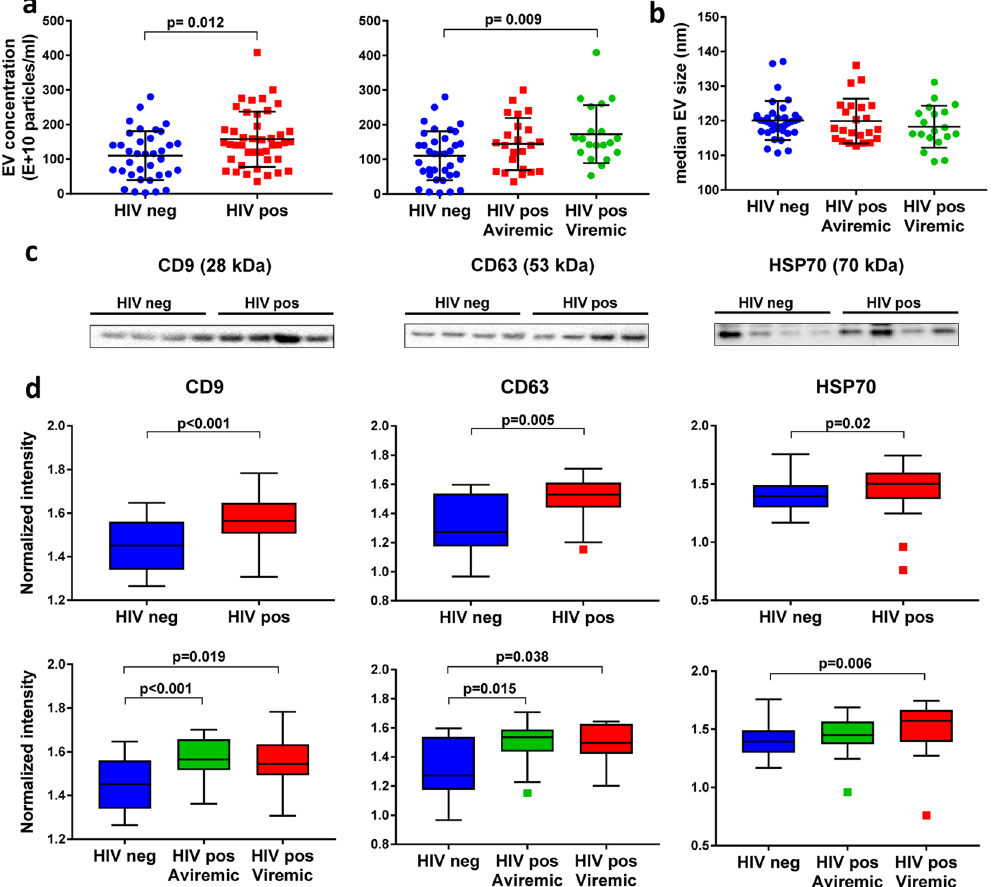
Figure 2. Plasma exosomes and exosome markers CD9, CD63, and HSP70 are elevated in viremic HIV-positive subjects on ART compared to controls. Exosome fractions were isolated from plasma (0.4 ml) of HIV-positive subjects (aviremic and viremic with viral load < 400 and 400–2500 HIV RNA copies/ml, respectively) and HIV-negative controls. Beeswarm plots show EV concentration ( a ) and median size ( b ) measured by NTA in aviremic (n = 23) and viremic (n = 20) HIV-positive versus HIV-negative subjects (n = 34). Horizontal bars represent means and error bars represent SD. ( c ) Proteins (25 μ g protein per lane) were separated by SDS- PAGE and immunoblotted with exosome marker antibodies against CD9, CD63, and HSP70. Representative blots from 4 HIV-negative and 4 HIV-positive samples are shown. Bands in each lane were normalized to corresponding EV numbers (full length blots for all samples are shown in Supplementary Figure S3). ( d ) Box plots in upper panel show exosome marker protein levels in HIV-positive (n = 37) versus HIV-negative subjects (n = 27). Box plots in lower panel show exosome marker protein levels in aviremic (n = 21) and viremic (n = 16) HIV-positive versus HIV-negative subjects (n = 27). Medians are represented by horizontal bars, boxes span the interquartile range (IQR), and whiskers extend to extreme data points within 1.5 times IQR. Outliers are plotted outside 1.5 times the IQR. p-values were calculated by Mann-Whitney U